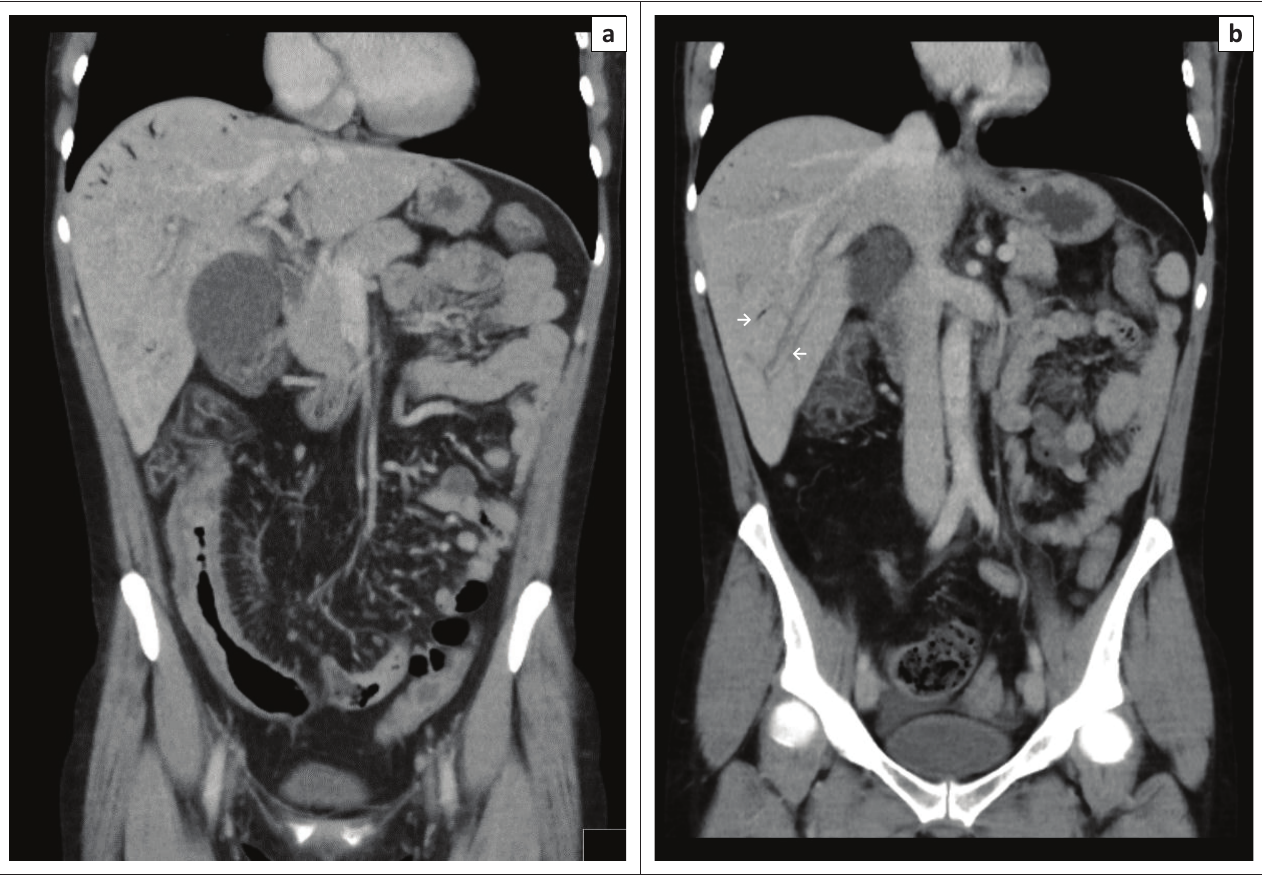
FIGURE 2: Coronal images from a CT abdomen demonstrating (a) circumferential mural thickening and enhancement of the terminal ileum with prominent vasculature resulting in a comb sign (b) portal venous gas with associated portal venous wall thickening and multiple filling defects in distal portal vein branches (arrows) consistent with